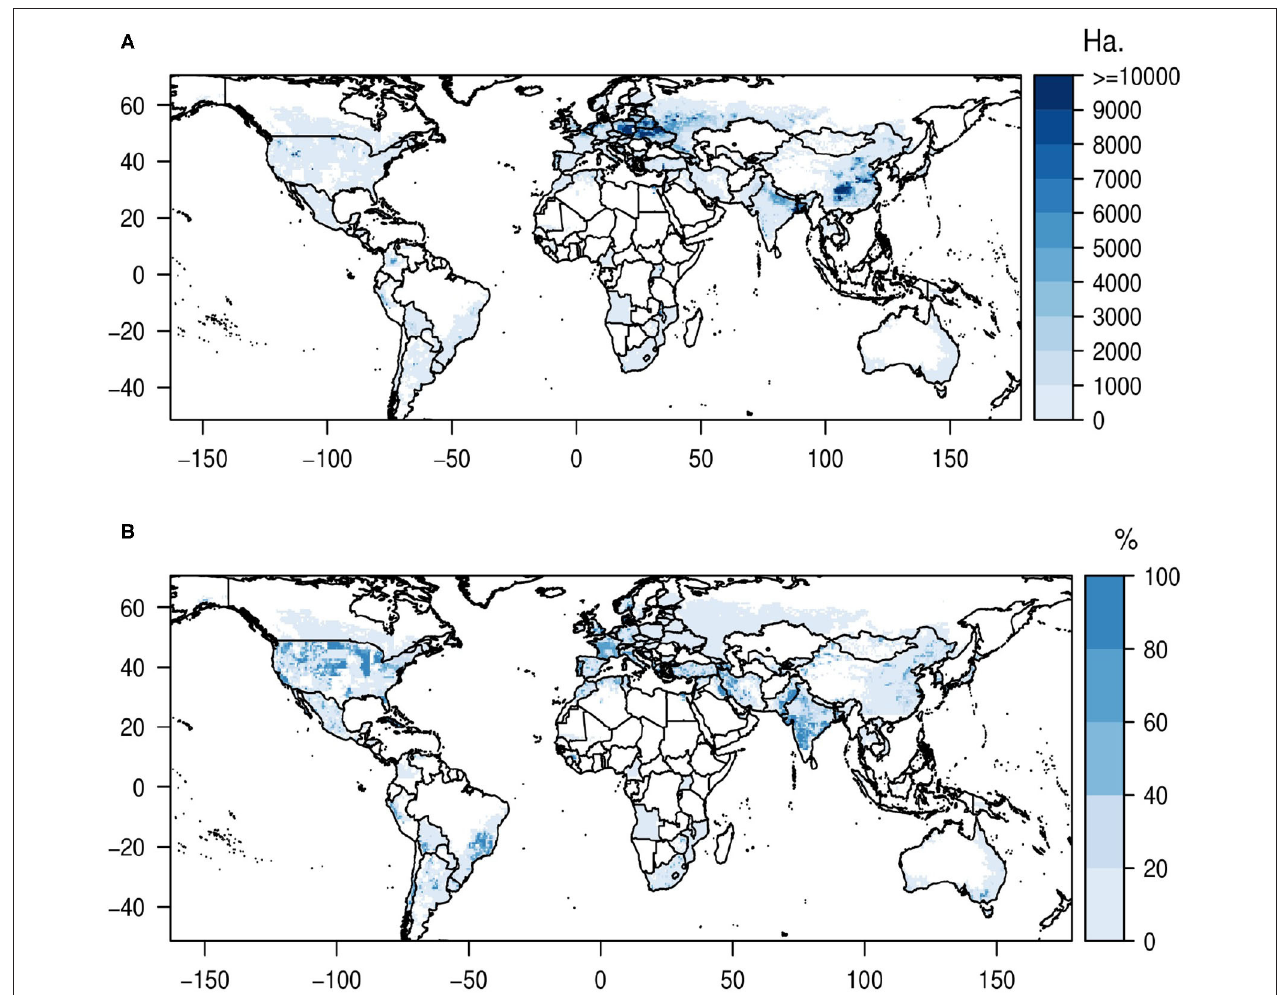
FIGURE 1 | (A) Growing areas per grid cell in hectares. (B) Percentage of potato area that is irrigated per grid